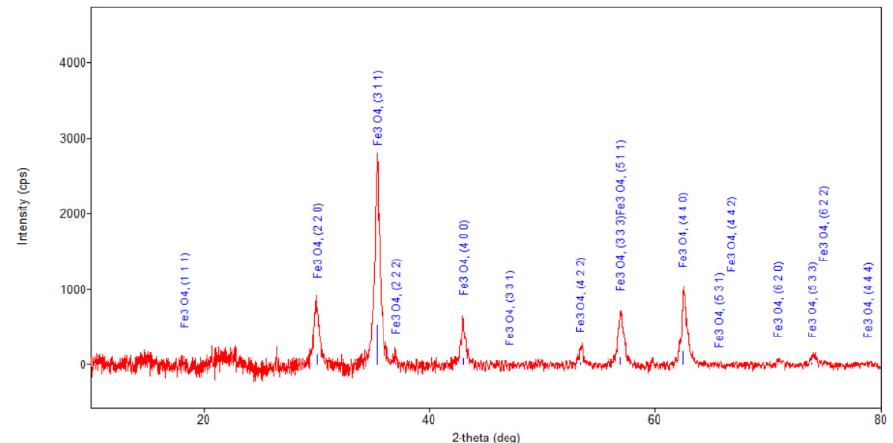
Figure 7. Powder XRD patterns of nano-carrier system.